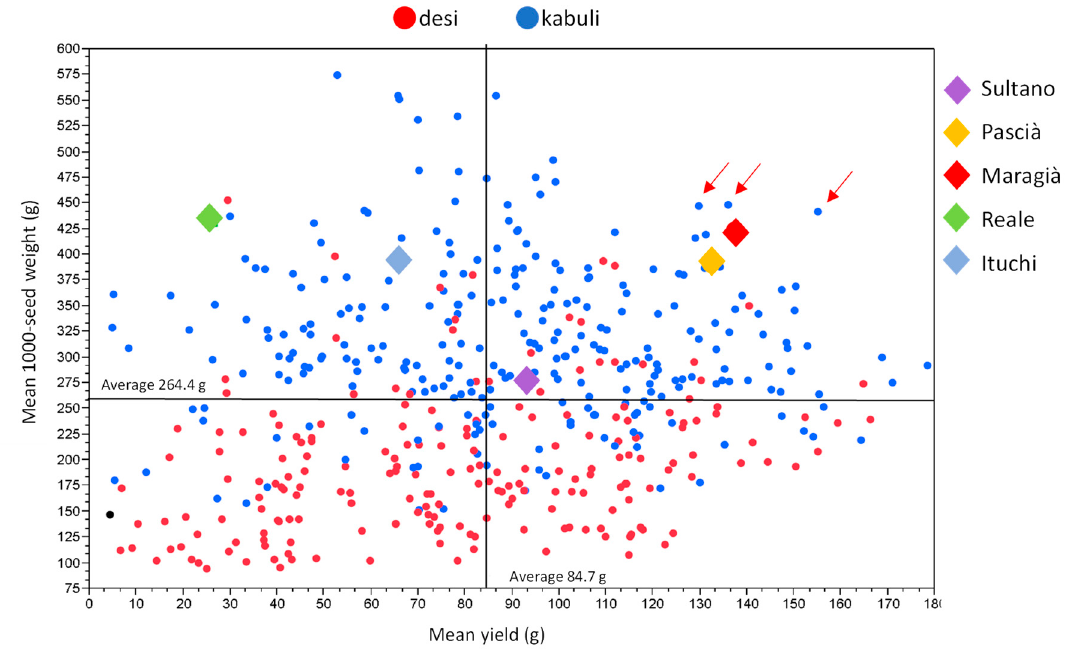
Figure 9. Scatter plot for yield and 1000-seed weight of the UNIVPM_Ca_core2 genotypes. Colored diamonds, cultivars used as controls. Red arrows, accessions (UNIVPM_Ca_1743, UNIVPM_CA_2119 and UNIVPM_Ca_2123) showing the highest yield and 1000-seed weight.